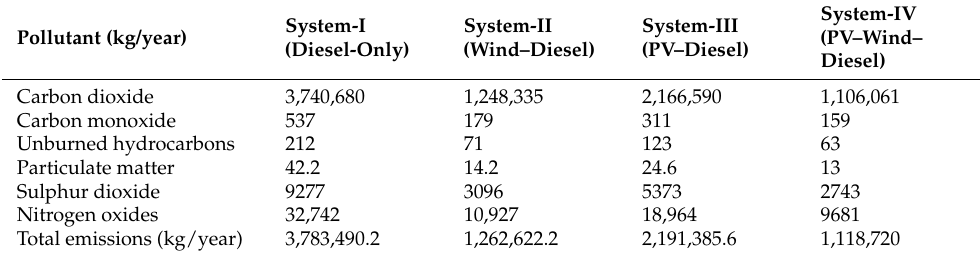
Table 9. Emissions in GHG components for different optimal system configurations.